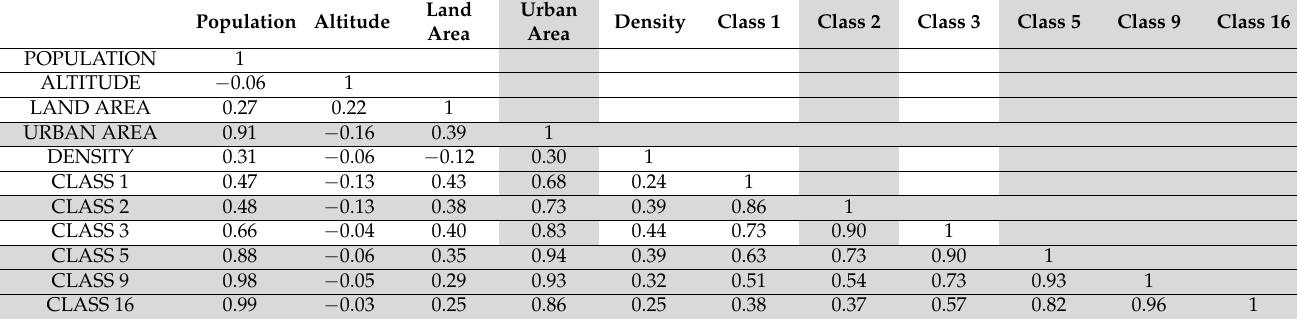
Table 1. Correlation between the structural variables of the